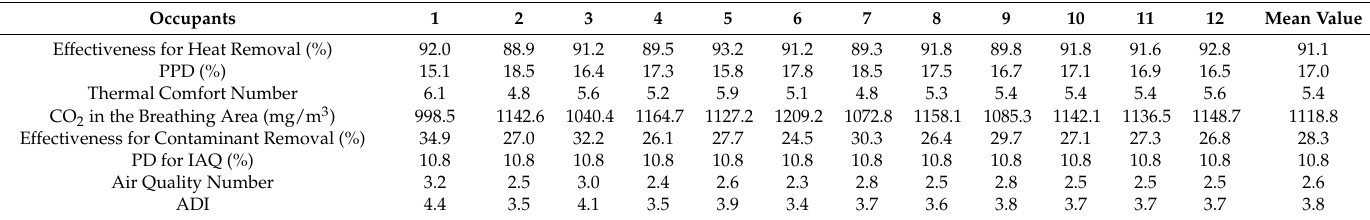
Table 5. ADI for an occupation of 12 persons, with an inlet air temperature of 24 ◦